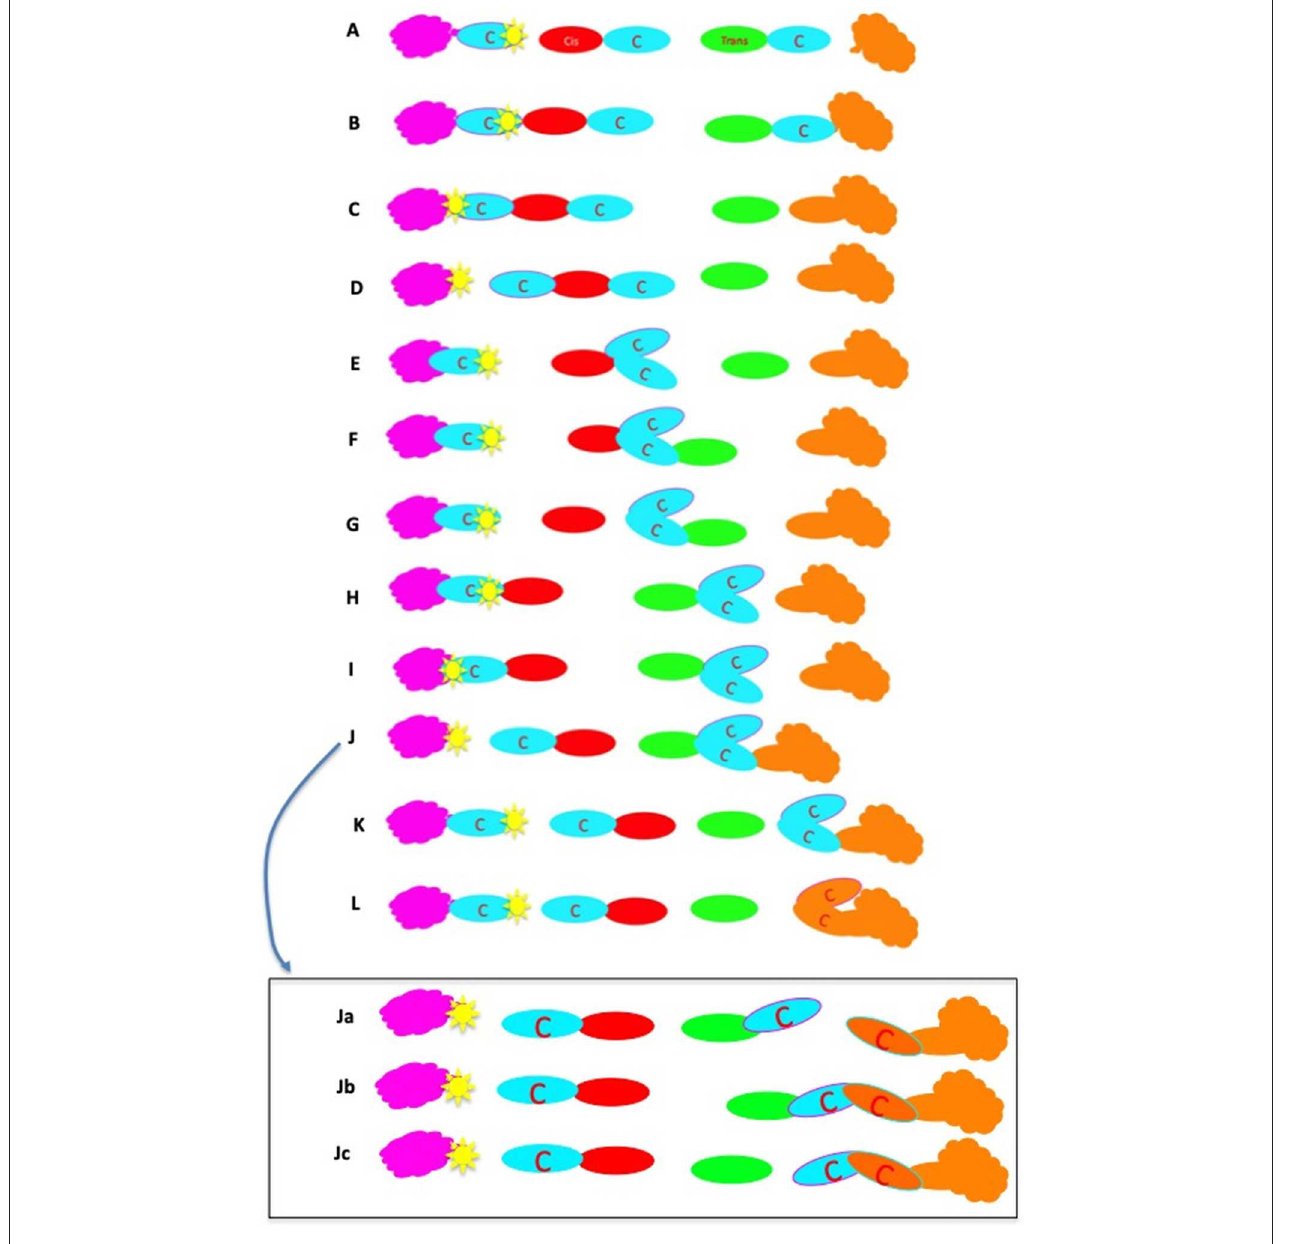
FIGURE 9 | Scheme of intra-Golgi transport in S. cerevisiae within the framework of the KARM. This scheme ensures maturation and progression of cargo domains. According to the main postulate of the KARM, to become separated, it is necessary to have initial fusion. Thus, fusion is the first event, and then fission (at another site) is the second event. The ER is magenta; artificial cargo is blue and indicated with the letter “C”; the cis- Golgi compartment is red; the trans Golgi compartment is green; the post-Golgi compartment is brownish; the exited cargo domain is surrounded with a red line. The situation that is shown here was formed after several rounds of cargo domain detachment from ERES, when most of the Golgi compartments already contain the artificial cargo. (A) The initial situation when most of the Golgi compartments contain cargo domains (blue). (B) Fusion of the cis- Golgi compartment (red) with ERES, and the trans- Golgi compartment (green) with the post-Golgi compartment (brownish). (C) Shift of the COPII coat (yellow) from the cargo domain (blue oval surrounded by a magenta ring). There is fission of the connections between the trans compartment (green) and the cargo domain, which is consumed by the post-Golgi compartment. (D) Detachment of the cis- Golgi compartment connected to two cargo domains from ERES (yellow). (E) Rotation of the cis- Golgi (for the sake of clarity). (F) Fusion between the trans- Golgi compartment and the cis- Golgi compartment connected to cargo domains. (G) Detachment after fission of the cis -Golgi compartment from the trans- Golgi compartment connected to cargo domains. (H) Fusion of the cis- Golgi compartment with ERES, where a new cargo domain covered with Sec31 is prepared. (I) Shift of the Sec31-coat (yellow) from the cargo. (J) Detachment of the cis- Golgi compartment connected with the new cargo domain from ERES, and fusion of the trans- Golgi part connected to cargo domains with the post-Golgi. (K) Detachment of the trans- Golgi compartment from the cargo domains. (L) The final stage when the cargo domain of interest is within the post-Golgi compartment. (Ja–c) The alternative consequence of the final events; namely, the cargo domains connected with the trans- Golgi compartment can be delivered to the post-Golgi one after